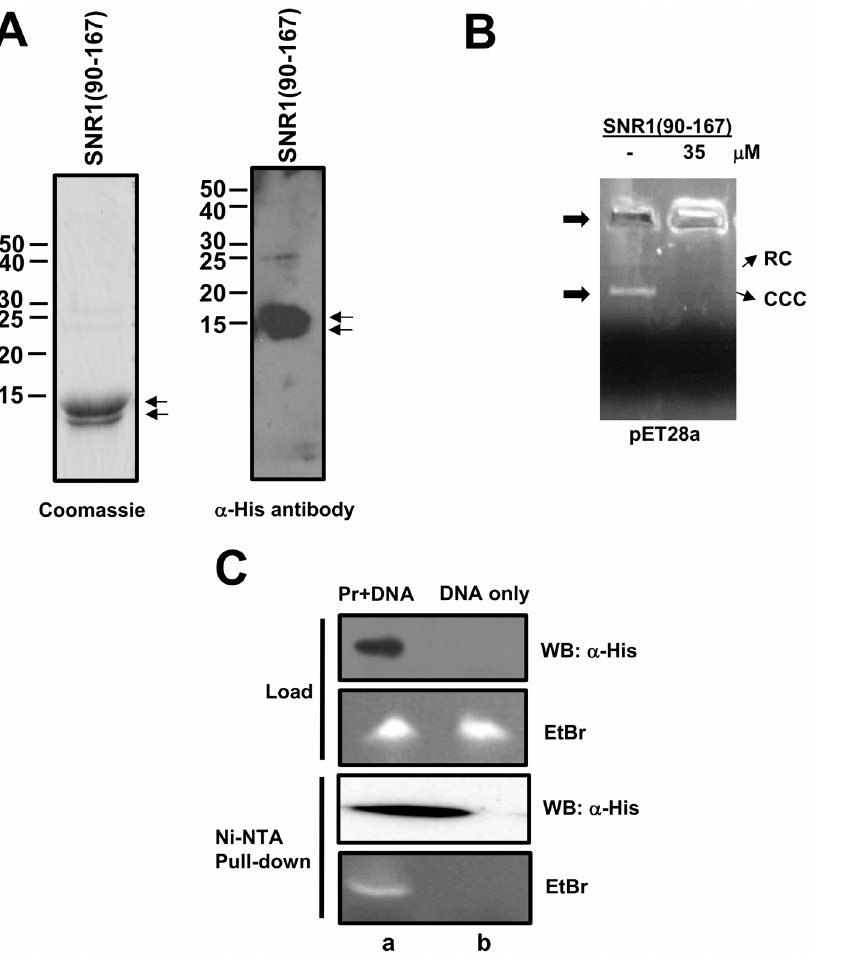
Figure 4. The proposed SNR1 DBD binds DNA. (A) Coomassie blue stained SDS-PAGE (left panel) and Western blot analysis (right panel), with a - His antibodies as probe, of recombinant, purified SNR1 DBD. (B) Agarose Gel Retardation Assay (AGRA) of SNR1 DBD. AGRA assay was carried out using pET28a (undigested, left panel) as substrate and indicated amount of polypeptide; RC: relaxed circular DNA, CCC: covalently closed circular DNA,. (C) Ni-NTA pull-down assays of SNR1 DBD incubated with U5 HIV-1 LTR DNA (lane a). Following washing, the beads containing bound complex were analyzed by western blot using a -His antibodies as probes to detect SNR1 DBD and 10% urea-PAGE followed by ethidium bromide staining to detect bound DNA. DNA only control (lane b) was processed and analyzed in the same manner. The loading controls are shown.